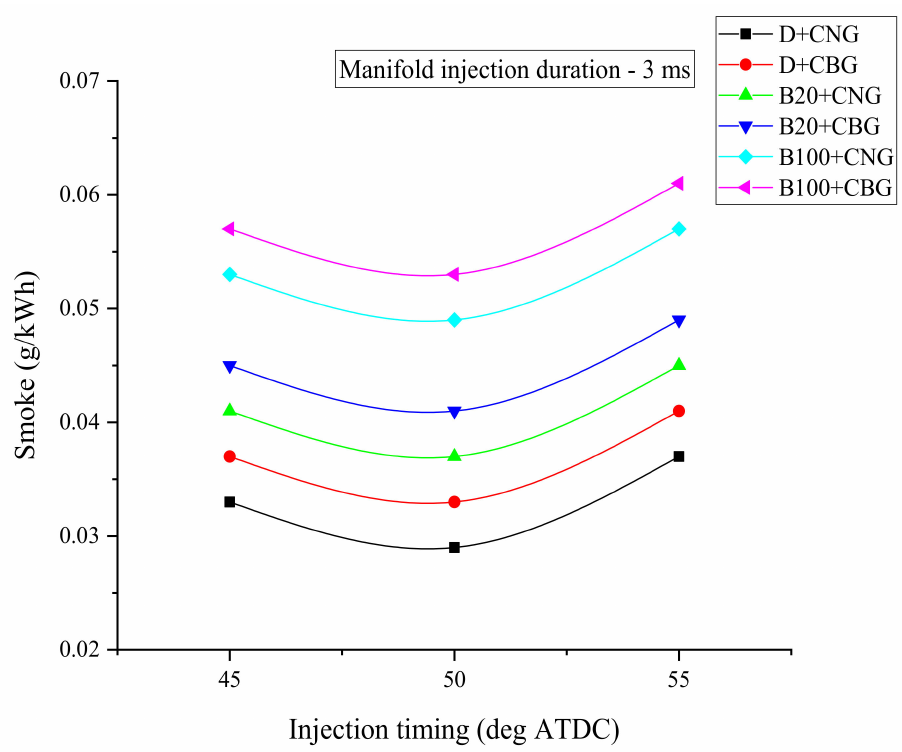
Figure 6. Variation of Smoke emissions with